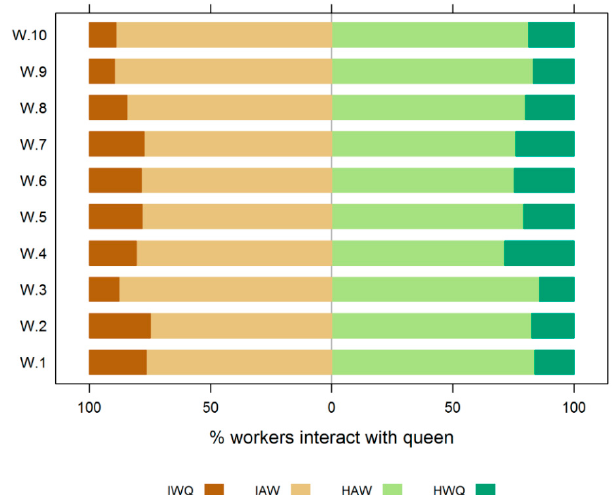
Figure 5. Attendance behavior of infected and healthy workers towards the queen. A small portion of healthy and infected workers stayed close to the screen in contrast to the majority of workers in both groups that did not attend across all trials and days, and there was no significant difference between inoculated and control workers with regards to queen attendance ( p = 0.320). IWQ: infected workers interact with queen, IAW: infected workers away from queen, HAW: healthy workers away from queen, HWQ: healthy workers interact with queen. Insects 2018 , 9 , x FOR PEER REVIEW